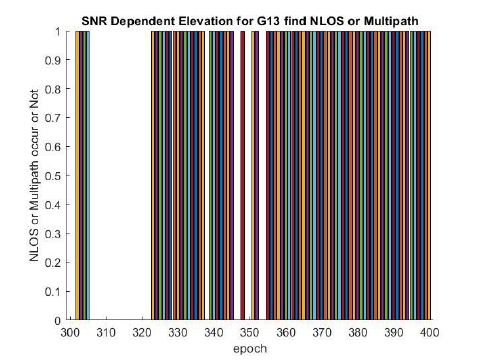
Figure 10. SNR Dependent Elevation find NLOS or Multipath Figure 13. CMCD find NLOS or Multipath for R3 for G13 ( In this figure, if multipath or NLOS detected bar shows 1, and ( In this figure, if multipath or NLOS detected bar shows 1, and if not shows 0. Also in this figure colors do not have special if not shows 0. Also in this figure colors do not have special meaning. ) meaning. )